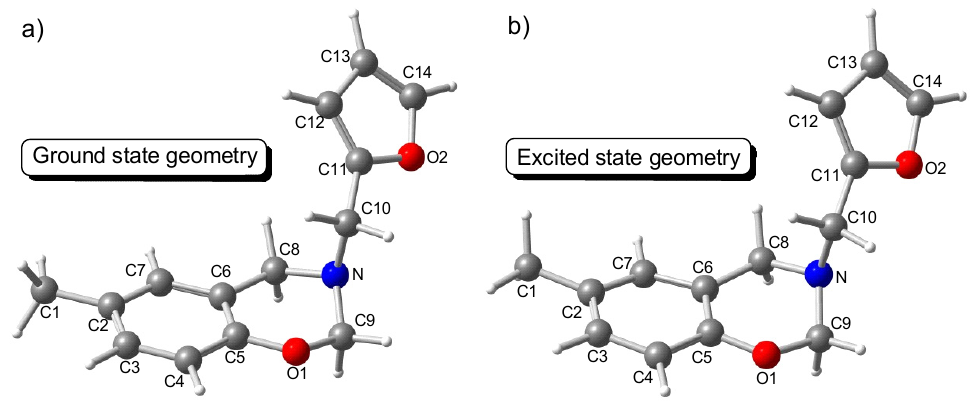
Figure 7. Optimized ( a ) ground state and ( b ) excited state geometries of the benzoxazine (I) at the PCM(acetonitrile)/B3LYP/6-311+G(d) and PCM(acetonitrile)/TD-B3LYP/6-311+G(d) levels of theory, respectively.